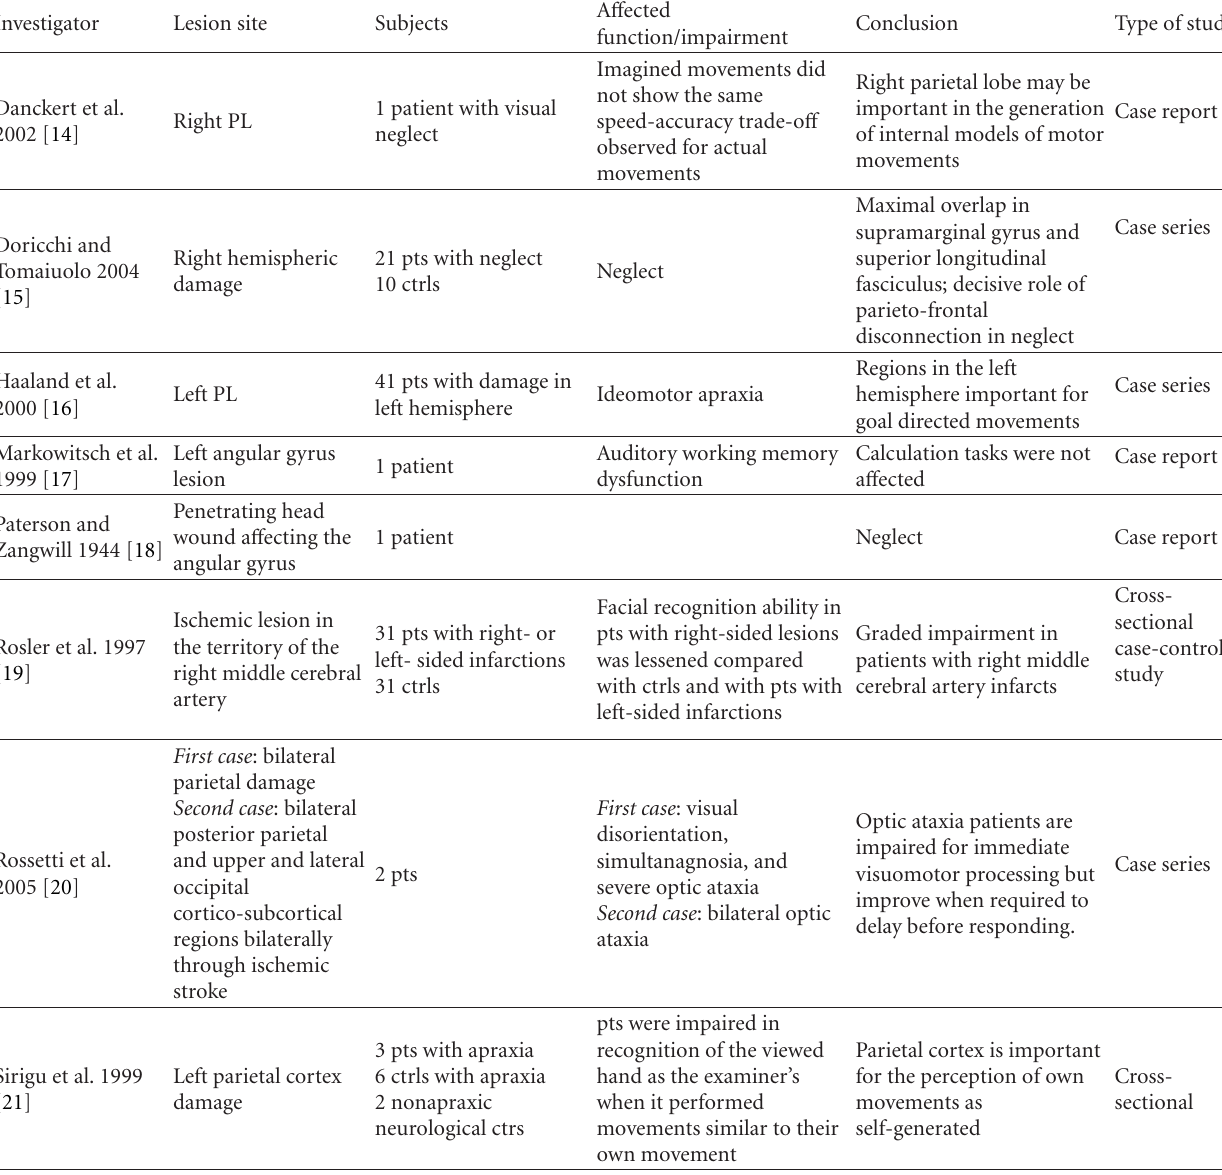
Table 1: Studies reporting lesions in parietal